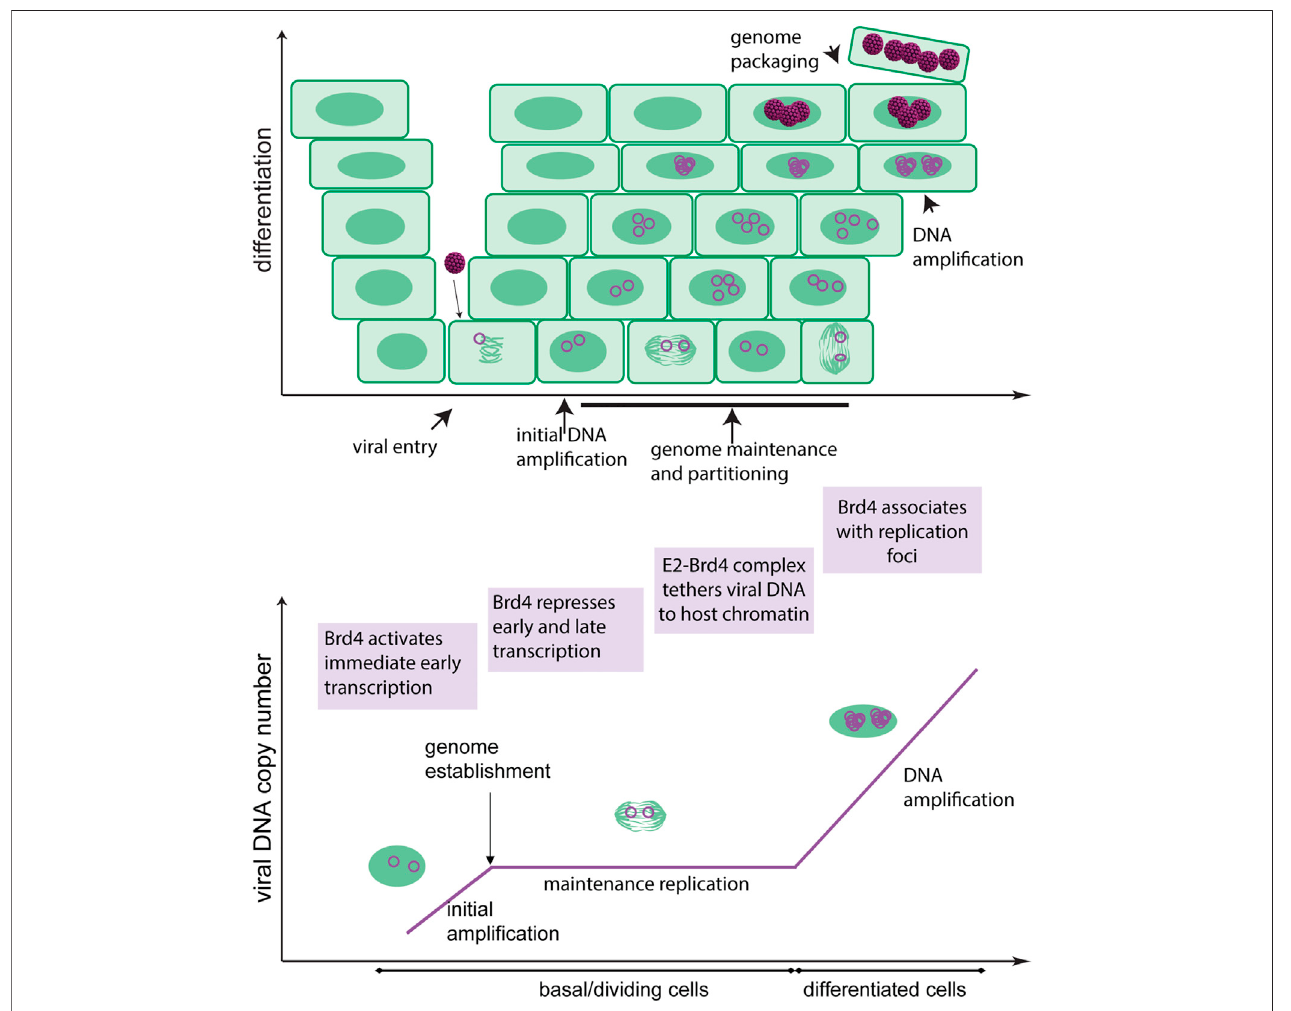
FIGURE 1 | Roles of Brd4 in the HPV infectious cycle. The upper diagram shows the differentiated layers of a strati fi ed epithelium. HPV accesses the basal cells through a microabrasion where it initiates a persistent infection. The viral genome is maintained as an extrachromosomal element within these cells and is partitioned to daughter cells by association with host chromosomes. As the infected cells differentiate, the viral genome ampli fi es to a high copy number in nuclear foci and is subsequently packaged into virions. The virions are shed from the surface of the epithelium in squames. The lower diagram shows the different stages of viral replication. The roles of Brd4 in the HPV infectious cycle are shown in purple